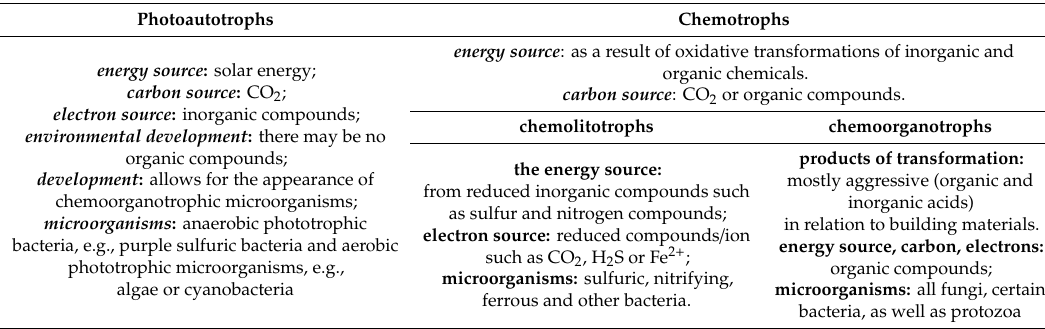
Table 3. Chemo and phototroph’s properties